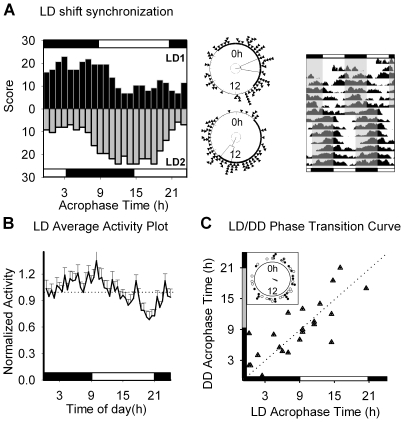
Light synchronization.A) Phase histogram of nematodes entrained to a light-dark cycle (12 h∶12 h 400 lux, 18°C), before and after a 6 h shift of the photoperiod. The middle panel shows the circular statistical analysis (Rayleigh test) for both situations (LD1: lights on at 0900 h; lights off at 2100 h; p<0.05, Rayleigh’s test, n = 80; LD2: lights on at 1500 h, lights off at 0300 h, p<0.05, Rayleigh’s test, n = 81) (the dotted circle inside the plot represents the significance threshold (p = 0.05), to compare with the resultant vector amplitude). The actogram on the right corresponds to average activity of the population. Gray shaded areas represent dark phases of the photoperiod. B) Average daily activity plot corresponding to 3 days of data from 20 nematodes synchronized to a 12 h∶12 h light-dark cycle. The analysis of 3 days of average activity indicates a significant difference between diurnal and nocturnal values (Maximum value  = 1.35±0.10 (10 h); Minimum value  = 0.68±0.09 (20 h); ANOVA test: p<0.0001). c) Comparison of locomotor activity acrophases between LD and the initial days under constant dark (DD) conditions, each triangle corresponds to the mean acrophase (cosinor analysis) of individual nematodes, calculated with the last 3 days of the pre-entrained condition (X axis) vs. the mean acrophase of the 3 first days of the constant dark condition (Y axis). Inset: Rayleigh test showing the phase angle of the population in entrainment (dark circles; r = 0.3 phi = 1.9 (7.3 h) n = 24) and the beginning of the constant condition post entrainment (white circles) (Rayleigh test: r = 0.3 phi = 2.0 (7.6 h) n = 24).